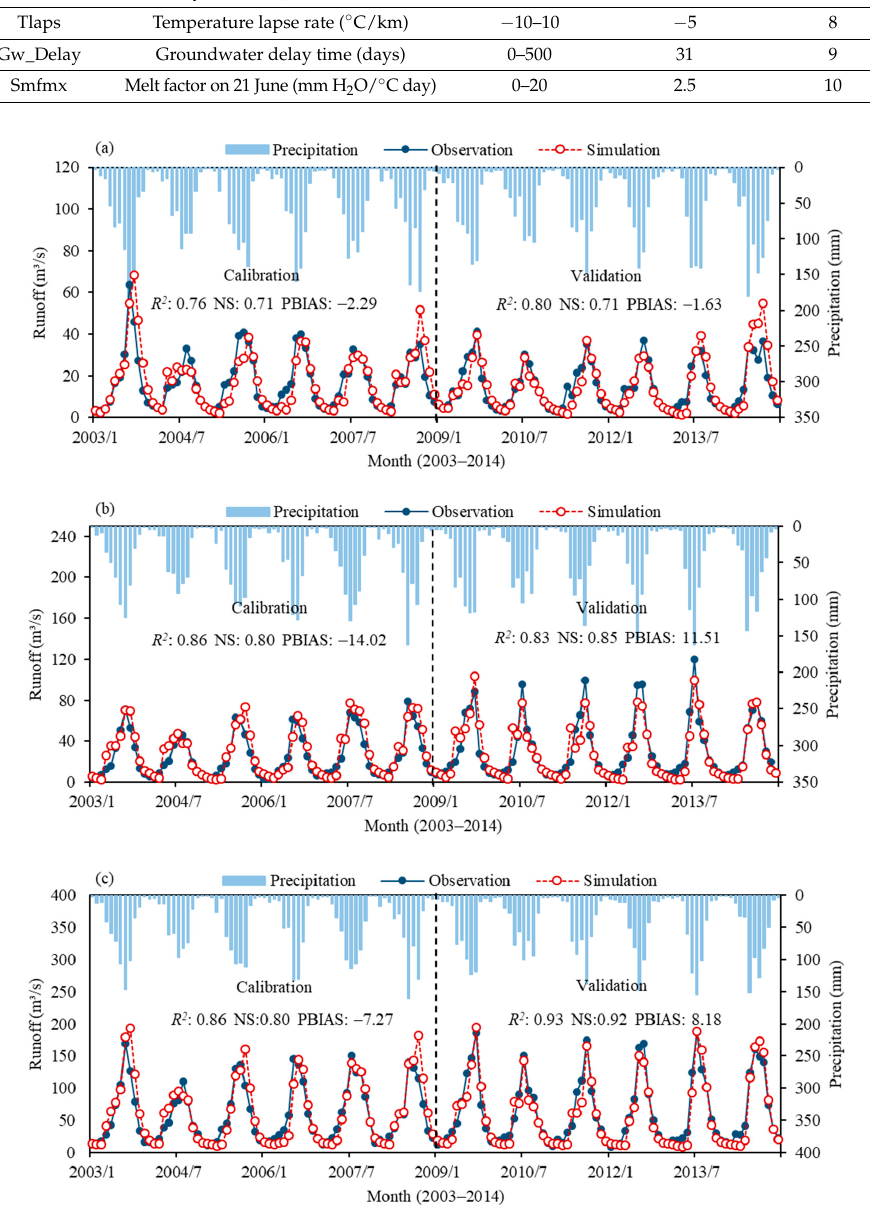
Figure 9. Monthly observation and simulated runoff of Qilian ( a ), Zhamashike ( b ), and Yingluoxia ( c